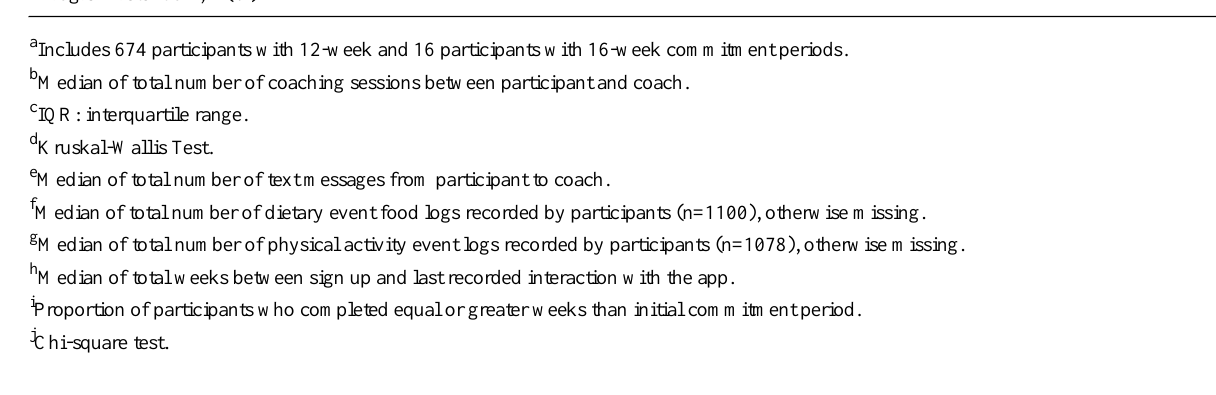
Table 3. Engagement of participants with mobile app–based program by age group, among all participants